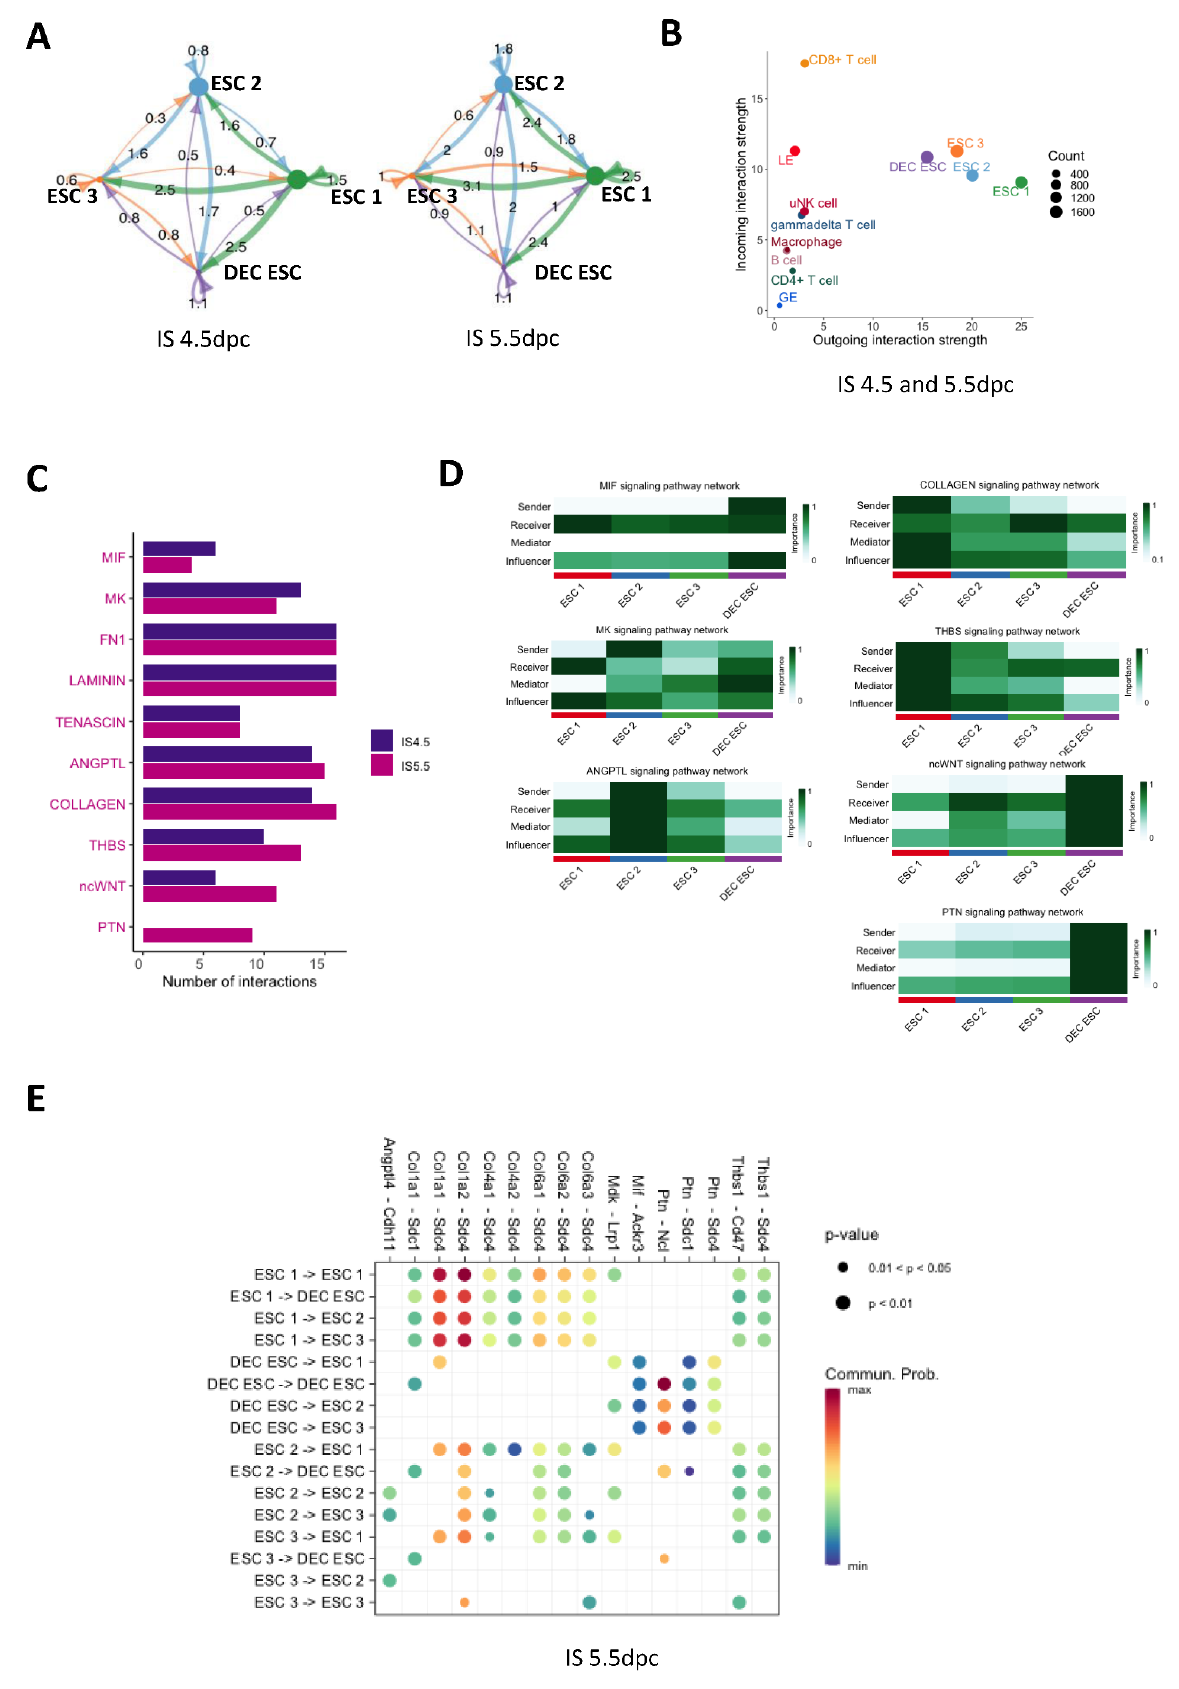
Figure 4. Ligand–receptor interactions between ESC subtypes in mouse implantation sites. ( A )